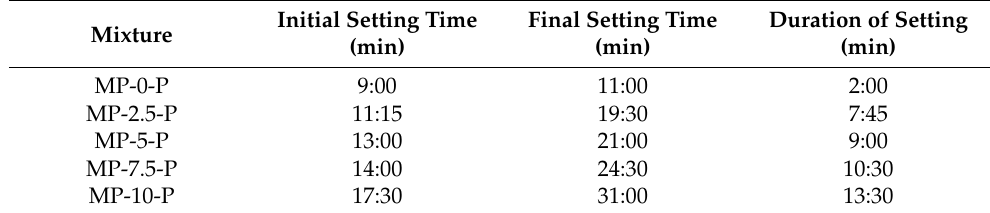
Table 6. Setting parameters of the fresh MKPC